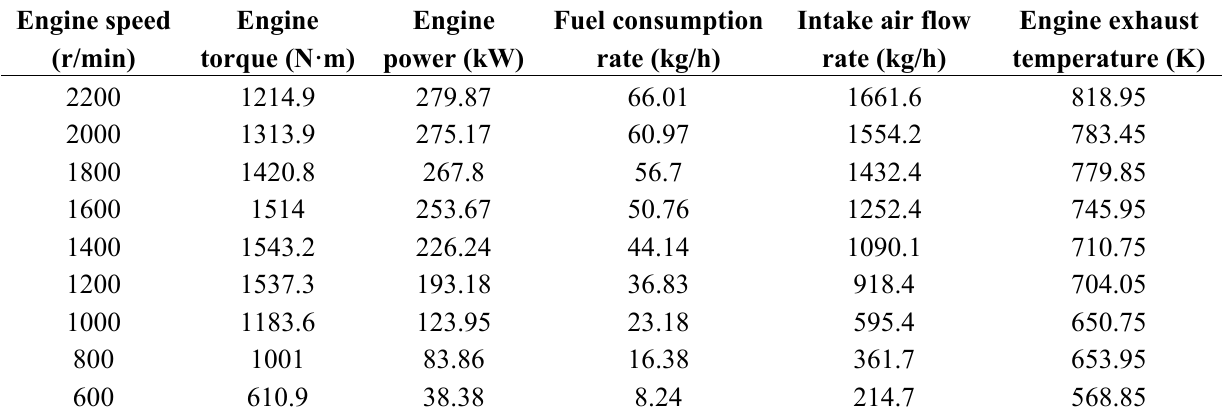
Table 2. Tested engine operating condition